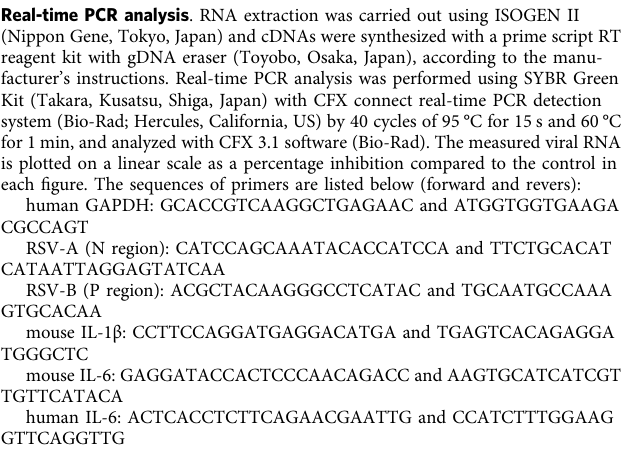
mouse IL-1 β : CCTTCCAGGATGAGGACATGA and TGAGTCACAGAGGA TGGGCTC mouse IL-6: GAGGATACCACTCCCAACAGACC and AAGTGCATCATCGT TGTTCATACA human IL-6: ACTCACCTCTTCAGAACGAATTG and CCATCTTTGGAAG